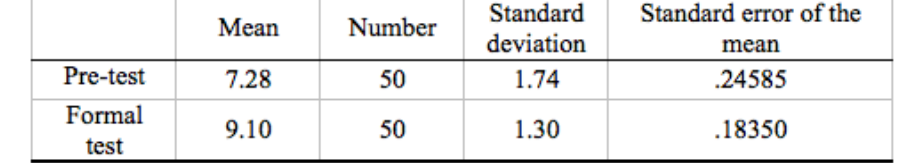
Results of number of questions with correct answers in the pre-test and formal